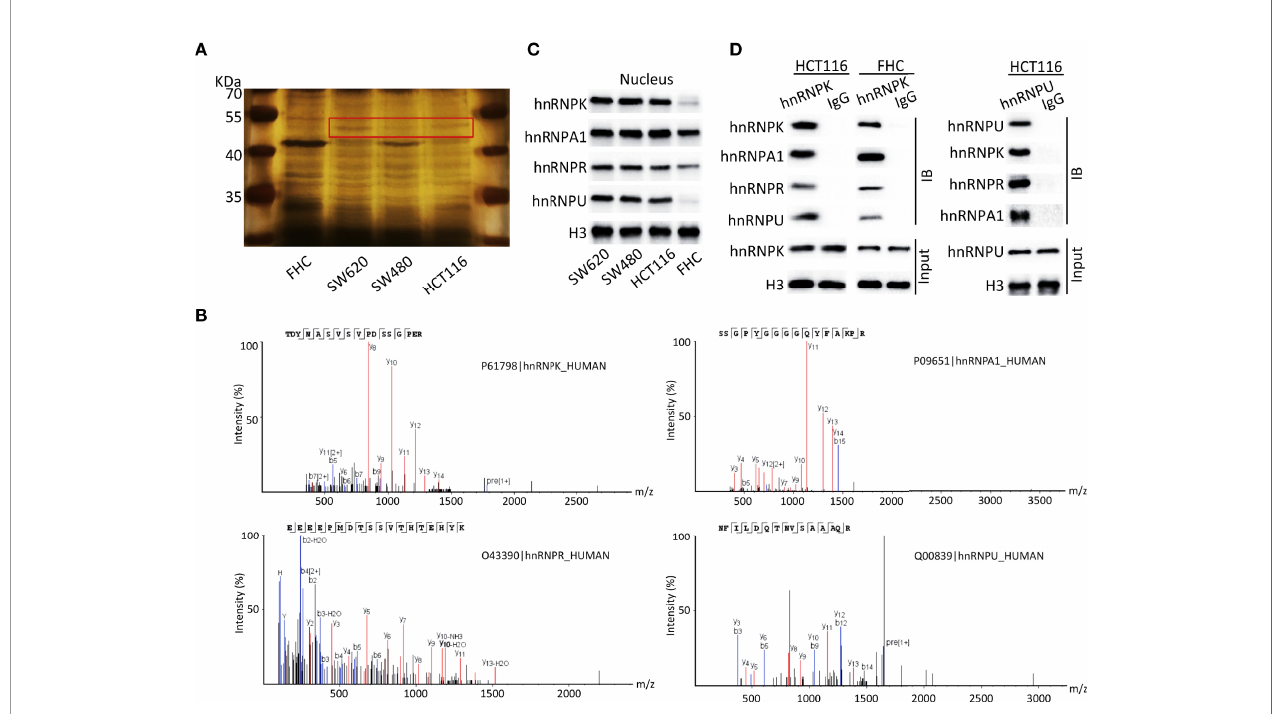
FIGURE 6 | HnRNPK/A1/R/U complex was identi fi ed and validated in human colorectal adenocarcinoma cell lines. (A) Nuclear proteins of HCT116, SW480, and SW620 cells were extracted, with FHC as the control. After SDS-PAGE and silver staining, a differential protein band with a molecular weight of 50-55 kDa was observed (red rectangle). In detail, more enrichment was observed in SW620 cells and less enrichment was observed in SW480 and HCT116 cells. Importantly, the total enrichment amount of colorectal adenocarcinoma cells was elevated compared with normal cells. (B) The protein band in red rectangle was excised, trypsinized, and analyzed by MS. With the best peptide-spectrum sequences, hnRNPA1 (P09651), hnRNPK (P61798), hnRNPR (O43390), and hnRNPU (Q00839) were identi fi ed. (C) WB assays were performed to validate the expressions of hnRNPA1, hnRNPK, hnRNPR, and hnRNPU in the nucleus, with histone H3 as the control. The results showed that hnRNPA1, hnRNPK, hnRNPR, and hnRNPU in the nucleus had higher expressions in colorectal adenocarcinoma cells compared with FHC cells. (D) The interaction between hnRNPK and hnRNPA1/R/U proteins was con fi rmed by Co-IP in HCT116 cells. To con fi rm the reliability of this result, the interaction between hnRNPU and hnRNPA1/R/K proteins was further con fi rmed in HCT116 cells. In FHC cells, the interaction between hnRNPK and hnRNPA1/R/U proteins was observed, which revealed that the hnRNPK/A1/R/U interaction was not speci fi c to cancer